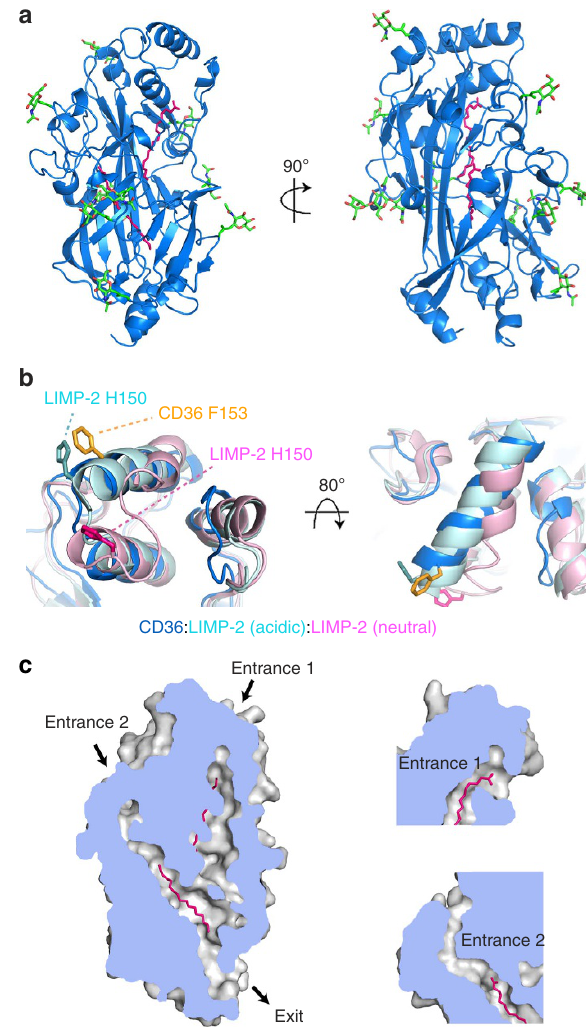
Figure 1 | The structure of CD36 and its binding of fatty acids. ( a ) The structure of CD36, shown in blue. The nine N -linked glycosylation sites and associated sugars are green while two palmitic acids are shown as pink sticks. ( b ) An alignment of CD36 (blue) with the structures of LIMP-2 at acidic (cyan) and neutral (pink) pH. Residues F153 from CD36 (orange) and H150 from LIMP-2 at acidic (light blue) and neutral (pink) pH are highlighted. ( c ) A section through a surface representation of CD36 showing the central core cavity occupied by two palmitic acids (pink). Insets show two putative entrances to this central